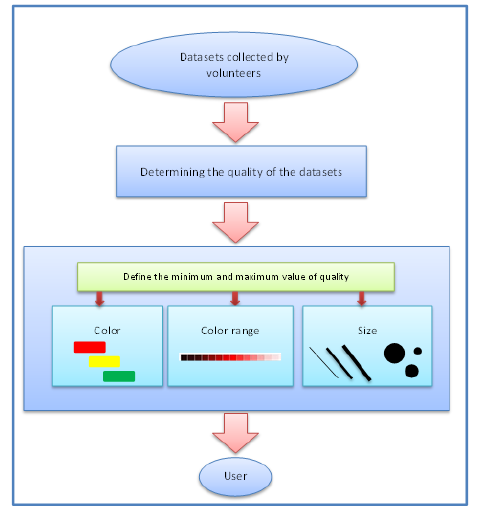
Figure 3. The proposed approach for representation of spatial quality information to the VGI user